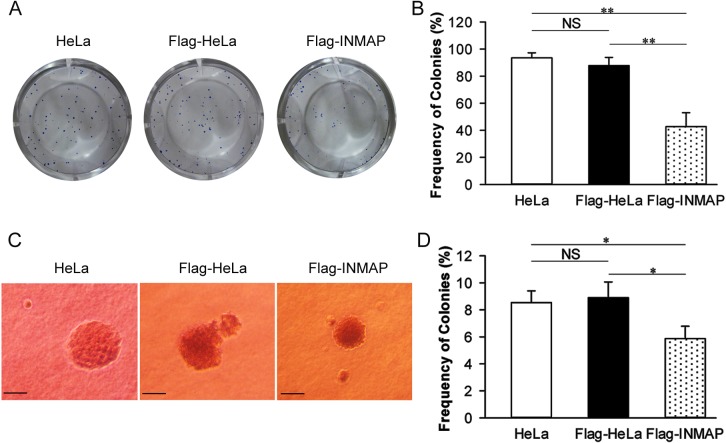

INMAP overexpression suppressed the growth of HeLa cells.(A, B). Colony formation of HeLa cells in monolayer cultures. Cells were stained with 10% Giemsa stain. Data are presented as mean ± SD; n = 4. ** and * represent significant differences with P-values under 0.01 and 0.05, respectively (the same below). NS, not significant. (C, D). Anchorage-independent colony growth assay in soft agar. Cells were seeded in 12-well plates containing 0.3% soft agar. After 6 weeks, the number of colonies with more than 50 cells was counted. Frequency of colonies of HeLa cells stably overexpressing INMAP in soft agar was analysed. Scale bars, 50 μm.